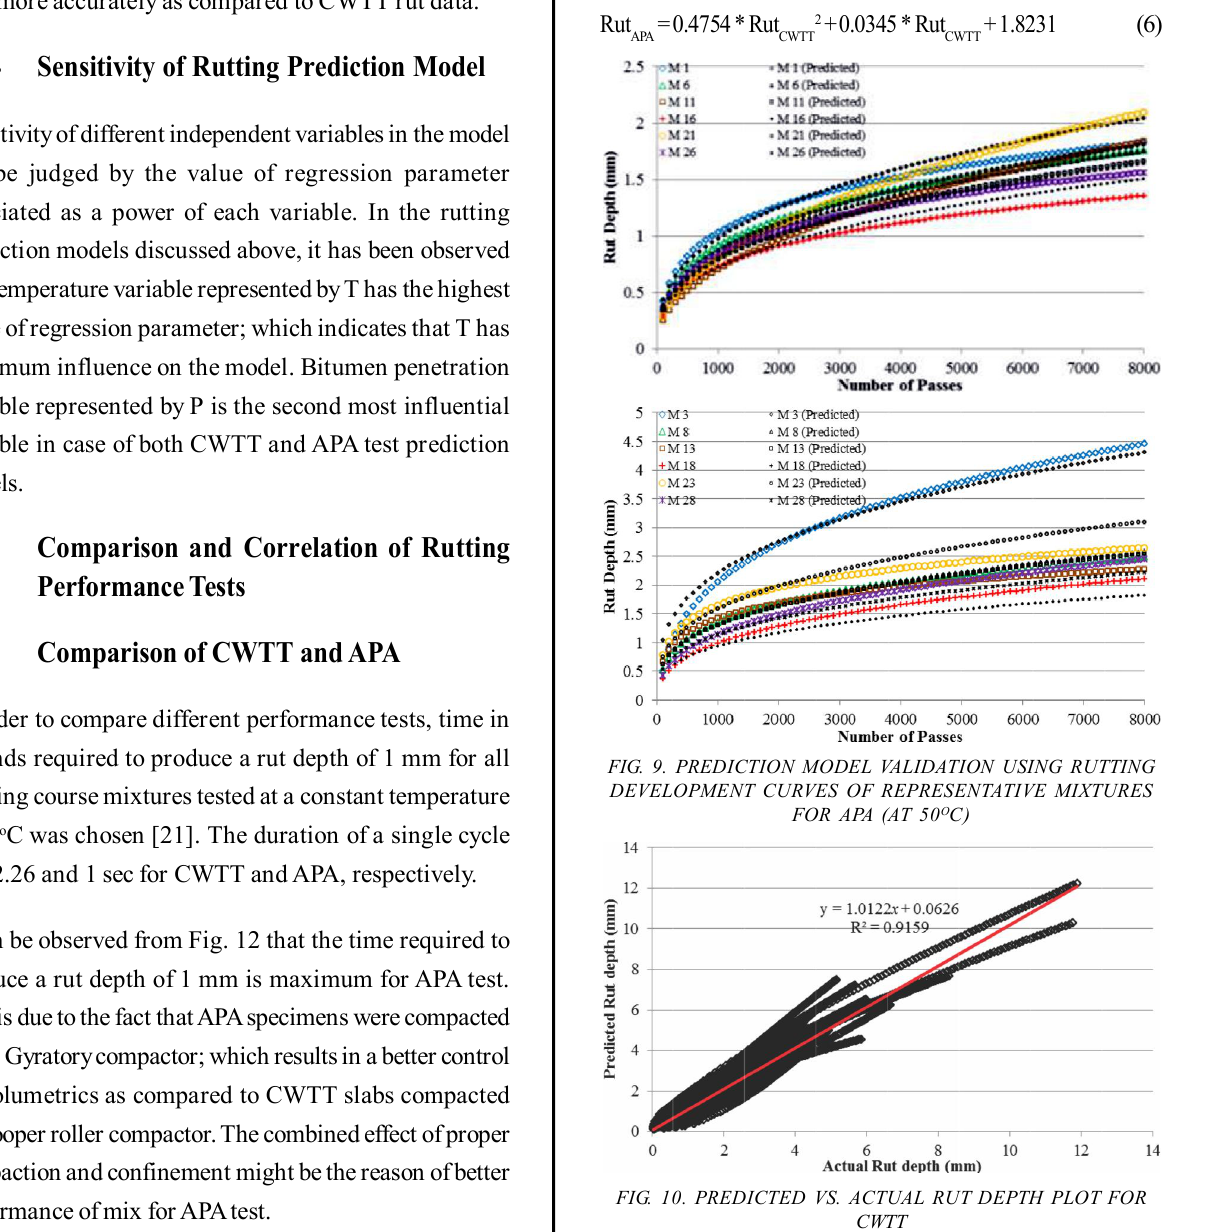
FIG. 10. PREDICTED VS. ACTUAL RUT DEPTH PLOT FOR